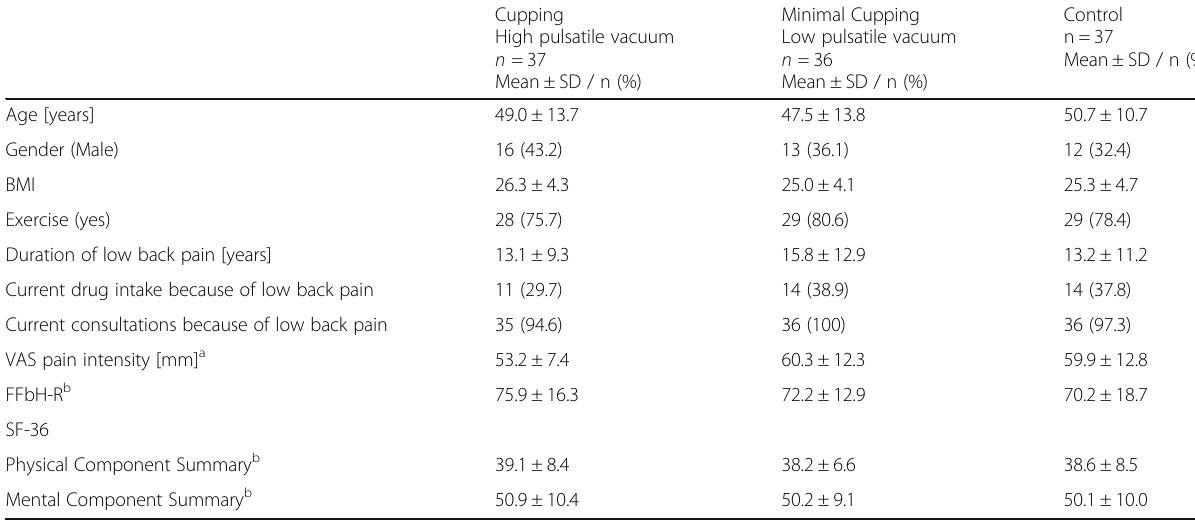
Table 1 Baseline characteristics of